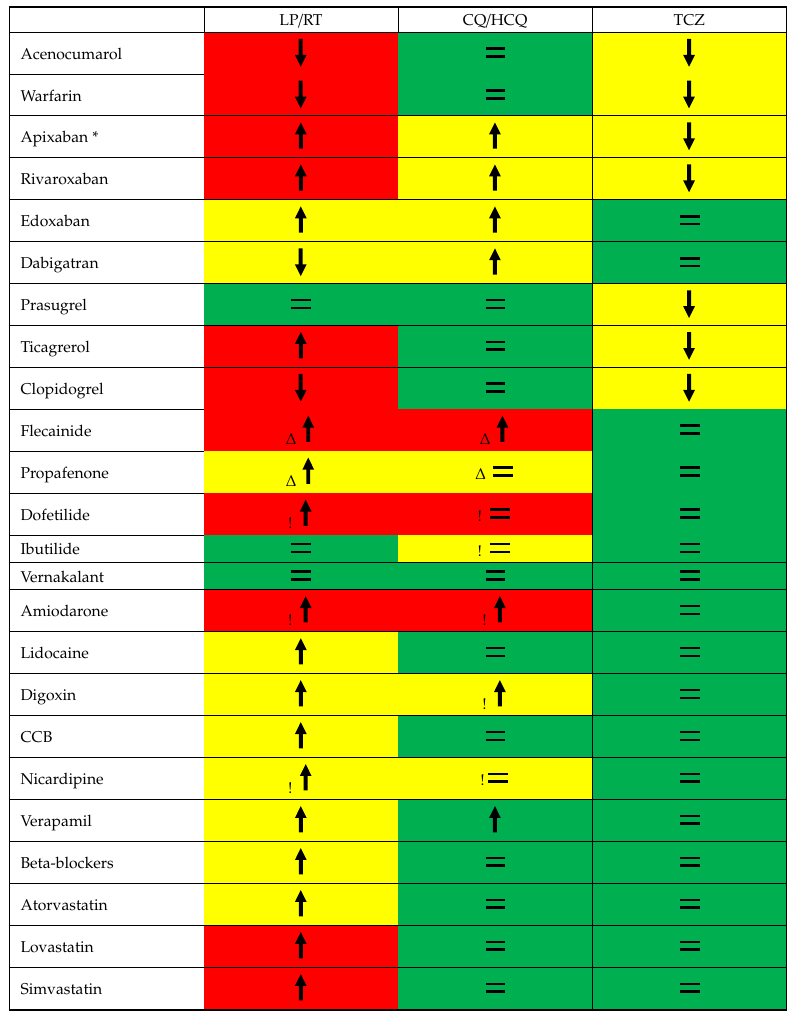
Table 3. Major cardiovascular drug interaction with anti-SARS-CoV-2 drugs.